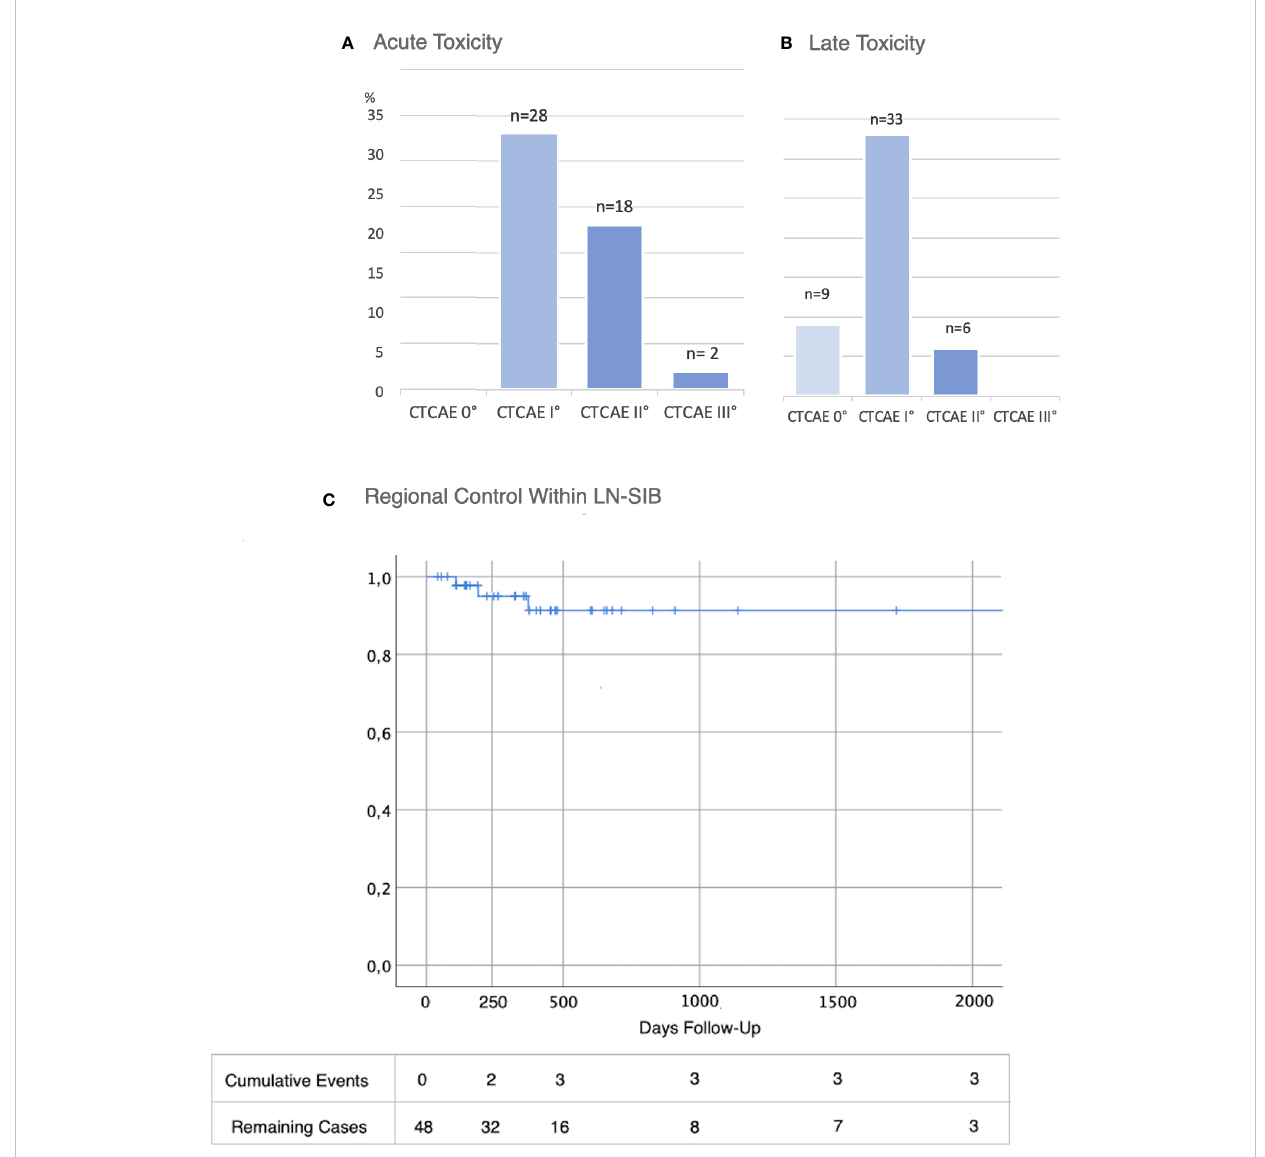
FIGURE 2 Toxicity and Oncological Outcome after LN-SIB. (A) Acute and (B) Late toxicity (CTCAE in % and total numbers (n=48)) (C) Regional control within